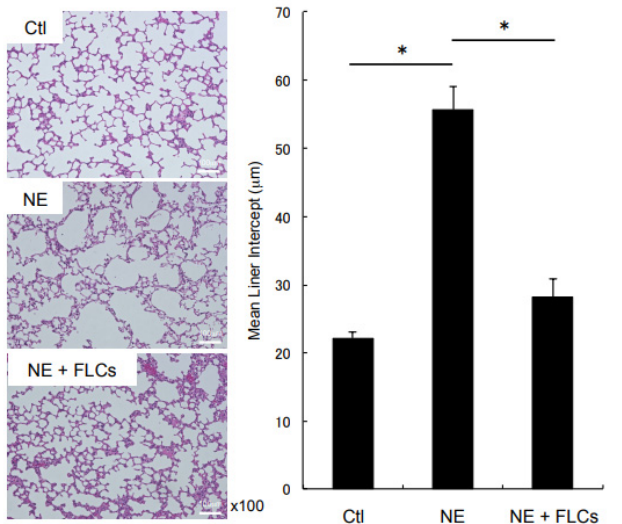
Figure 2. Representative lung sections showing H&E staining from control and 4 weeks after NE administration with or without FLCs transfer. The size of the alveolar space was evaluated by measurement of MLI. * p < 0.05, n = 8 for each. H&E: hematoxylin and eosin, Ctl: control, NE: neutrophil elastase, FLCs: fetal lung cells, MLI: mean liner intercept.